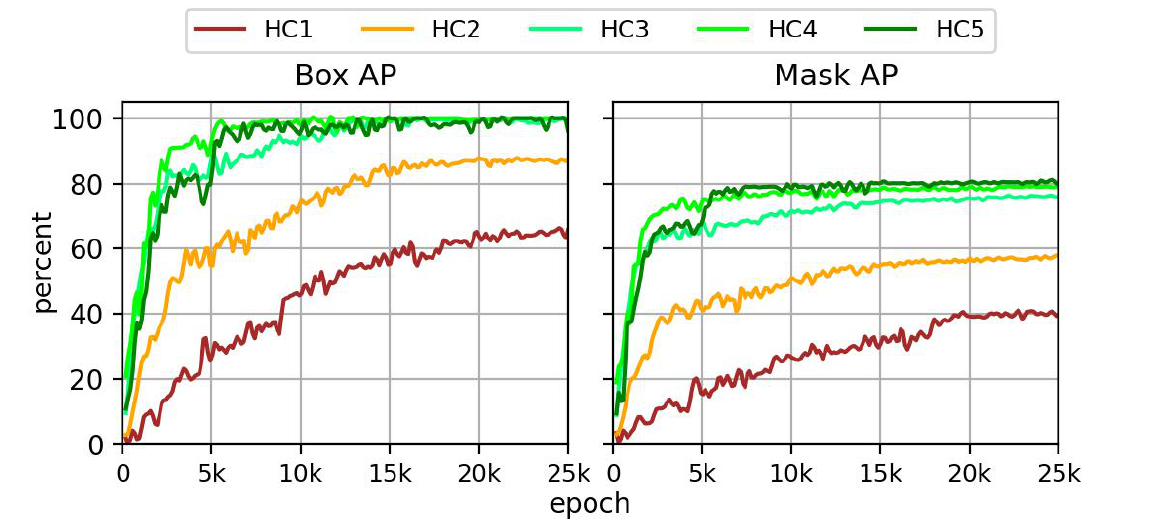
Figure 10. Average precision for box locations and mask areas delimitation for each health class at different training